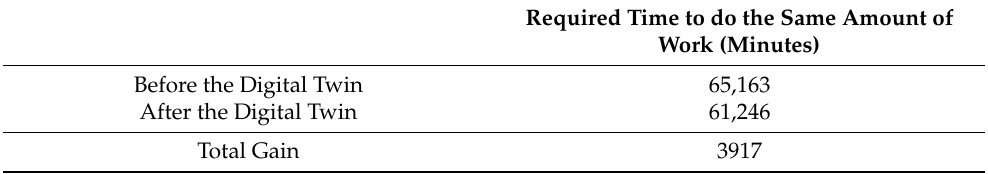
Table 7. Daily working time required to do the same amount of work before and after using the digital twin.